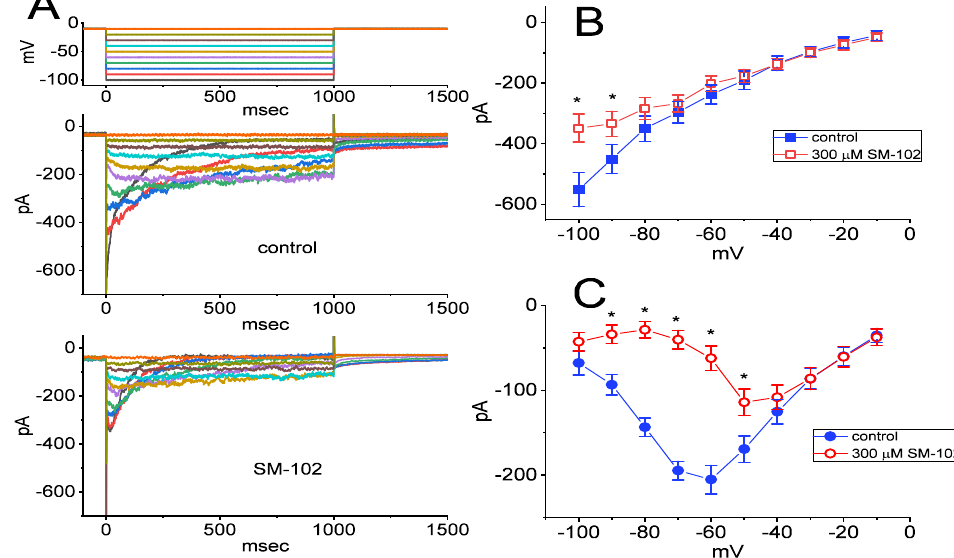
Figure 3. Inhibitory effect of SM-102 on current versus voltage ( I–V ) relationship of I K(erg) identified in GH 3 cells. In these experiments, cells were allowed to be bathed in high-K + , Ca 2+ -free solution containing 1 µ M TTX and 0.5 mM CdCl 2 and we filled up the electrode by using K + -enriched